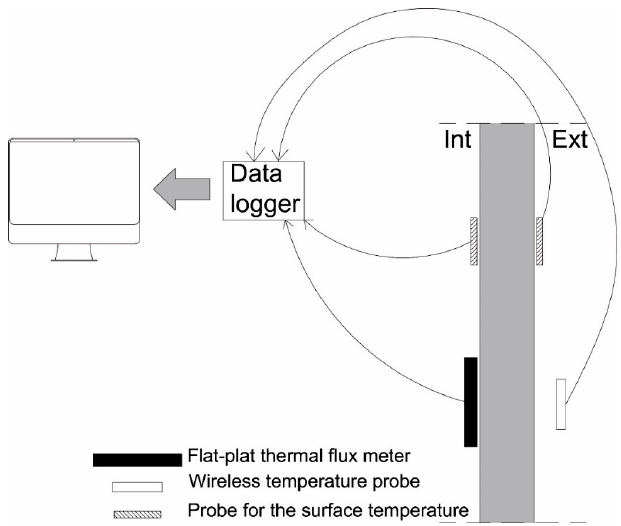
Figure 1. The graph showing the placement of the measurement devices on the wall. Table 1. Technical